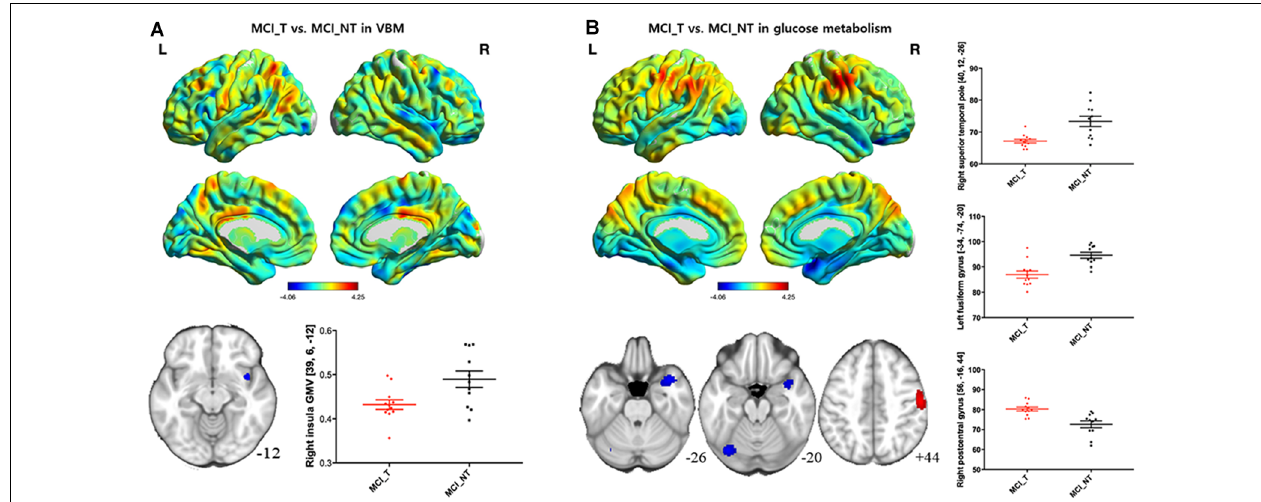
FIGURE 2 | Brain regions showing structural and metabolic differences in MCI_T, compared with MCI_NT. (A) Three-dimensional visualization of comparison of MCI_T with MCI_NT in gray matter (GM) volumes by voxel-based morphometry (VBM). The red-spectrum color indicates the MCI_T-increase in GM volumes, and blue-spectrum color indicates the MCI_T-decrease in GM volumes compared with MCI_NT. MCI_T showed a significant decrease in GM volume, compared with MCI_NT (middle). The bottom figure shows a scatter plot of individual GM volume in the region showing significant volume reduction. The horizontal lines represent the mean and standard error of the mean ( ± SEM). (B) Three-dimensional visualization of comparison of MCI_T with MCI_NT in mean metabolic uptake of [ 18 F]fluoro-2-deoxyglucose-positron emission tomography (FDG-PET). The red-spectrum color indicates the MCI_T-increase in metabolism, and blue-spectrum color indicates the MCI_T-decrease in metabolism compared with MCI_NT. Middle figures indicate brain regions showing significant glucose metabolic differences, in which red color indicates higher metabolism and blue color indicates lower metabolism in the MCI_T compared with the MCI_NT. The bottom figure shows a scatter plot of individual glucose metabolism in the regions showing significantly increased or decreased metabolic uptakes. The horizontal lines represent the mean and standard error of the mean ( ± SEM; p < 0.005 uncorrected, k >